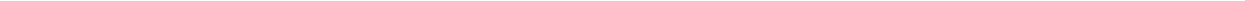
Fig. 3 Actin is required for centriole stability in mature ependymal cells. a F-actin (phalloidin, grey) and centrioles (FOP, red) in mature ependymal cells from explants treated with DMSO or 1 or 2 μ M cytochalasin-D (CytoD) for 12 or 40 h showing concentration- and time-dependent actin impairment; cell borders and centriolar patches are outlined with dashed white and red lines, respectively. b Representative 200 ms kymographs of motile cilia in brain slices treated for 40 h with DMSO or 2 μ M cytochalasin-D. The graph displays the ciliary beating frequency (Hz) that was not affected by the drug. Error bars represent the sem of n = 48 cells for DMSO- and CytoD-treated explants, from three independent experiments; P -values were determined with the Mann-Whitney test; ns, P > 0.05. c Representative images of Centrin2-GFP + centriolar patches in mature ependymal cells treated with DMSO or 1 or 2 μ M cytochalasin-D for 12 to 40 h. d Representative quanti fi cation of the number of centrioles per cell in lateral wall explant at P15 with contralateral brain of the same animal treated with DMSO or cytochalasin-D at 1 μ M for 40 h. Error bars represent the sem of n = 301 cells for DMSO- and n = 93 for CytoD-treated explants, from one representative animal out of 6; P -values were determined with the Mann – Whitney test; *** P ≤ 0.0001. e – f Fold change in centriole number relative to DMSO-treated contralateral brain in lateral ventricles treated with 1 or 2 μ M cytochalasin-D for 6 up to 40 h. A time- ( e ) and dose- ( f ) dependent reduction in the number of centrioles was observed following actin depolymerisation; P -values were determined by one-way ANOVA followed by Dunn ’ s multiple comparison test. Error bars represent the sem of for the dose dependent experiments, n = 389, 388 and 940 cells for DMSO-, CytoD 1 µ M- and CytoD 2 µ M-treated explants, respectively, from at least three independent experiments. For the time-dependent experiments, n = 2852, 704, 587 and 889 cells for DMSO-, CytoD 6h-, CytoD 12h- and CytoD 40 h-treated explants from at least three independent experiments. *** P ≤ 0.0001. * DMSO vs. CytoD 6 h P = 0.0287. *CytoD 12 h vs. CytoD 40 h, P = 0.0484. Scale bars = 5 μ